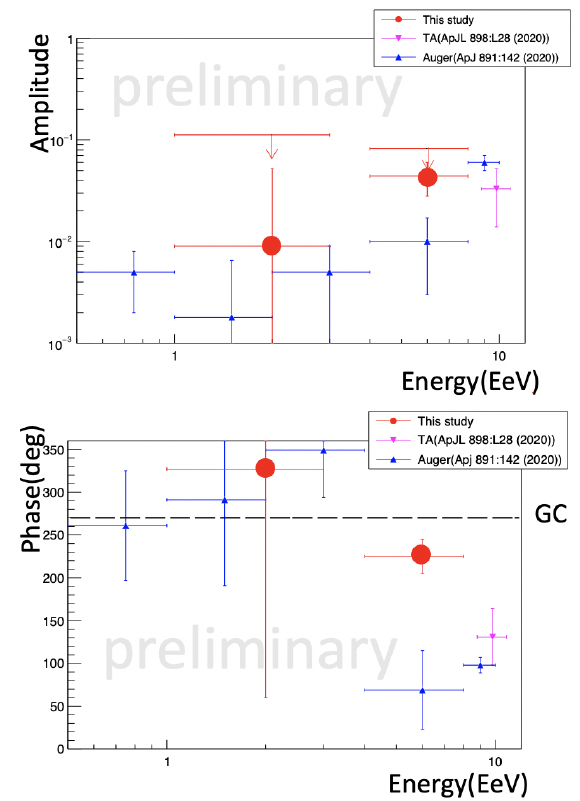
Figure 8. The measured amplitude with their upper limits of 99% confidence level and phase using both TALE SD and TA SD. The obtained results are compared with the result reported from Pierre Auger Collaboration [6,